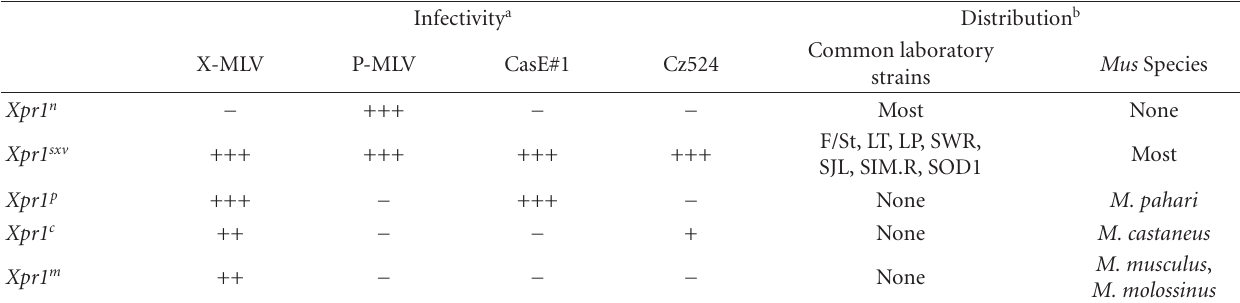
Table 1: Functional variants of the XPR1 receptor in